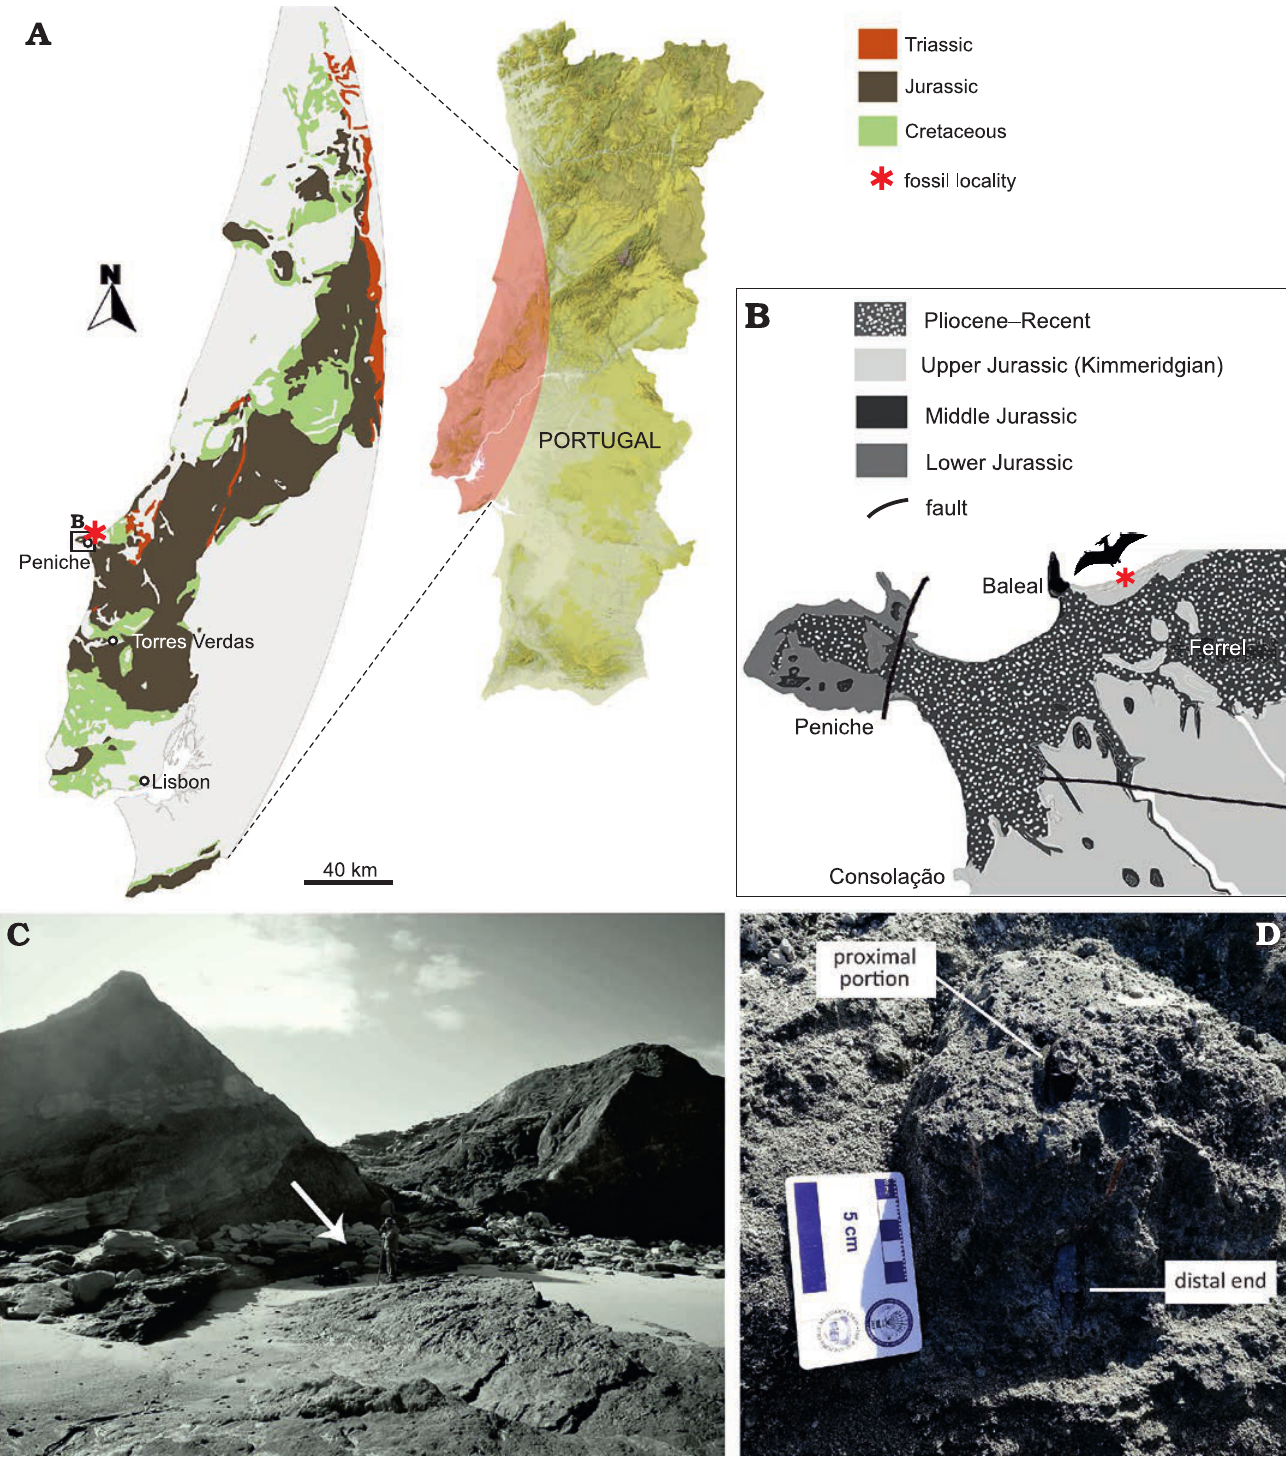
Fig. 1. Geological overview of the locality of SHN.013 in Portugal. A . Map of Portugal, with a focus on the geology of the Peniche area. B . Close-up of the Atlantic coast near Peniche, showing the age of the sediments. C . Specimen excavation site, the arrow points towards the location of the specimen. D . SHN.013 at the moment of discovery, after removing the loose sediment to identify the extension of the bone at its distal